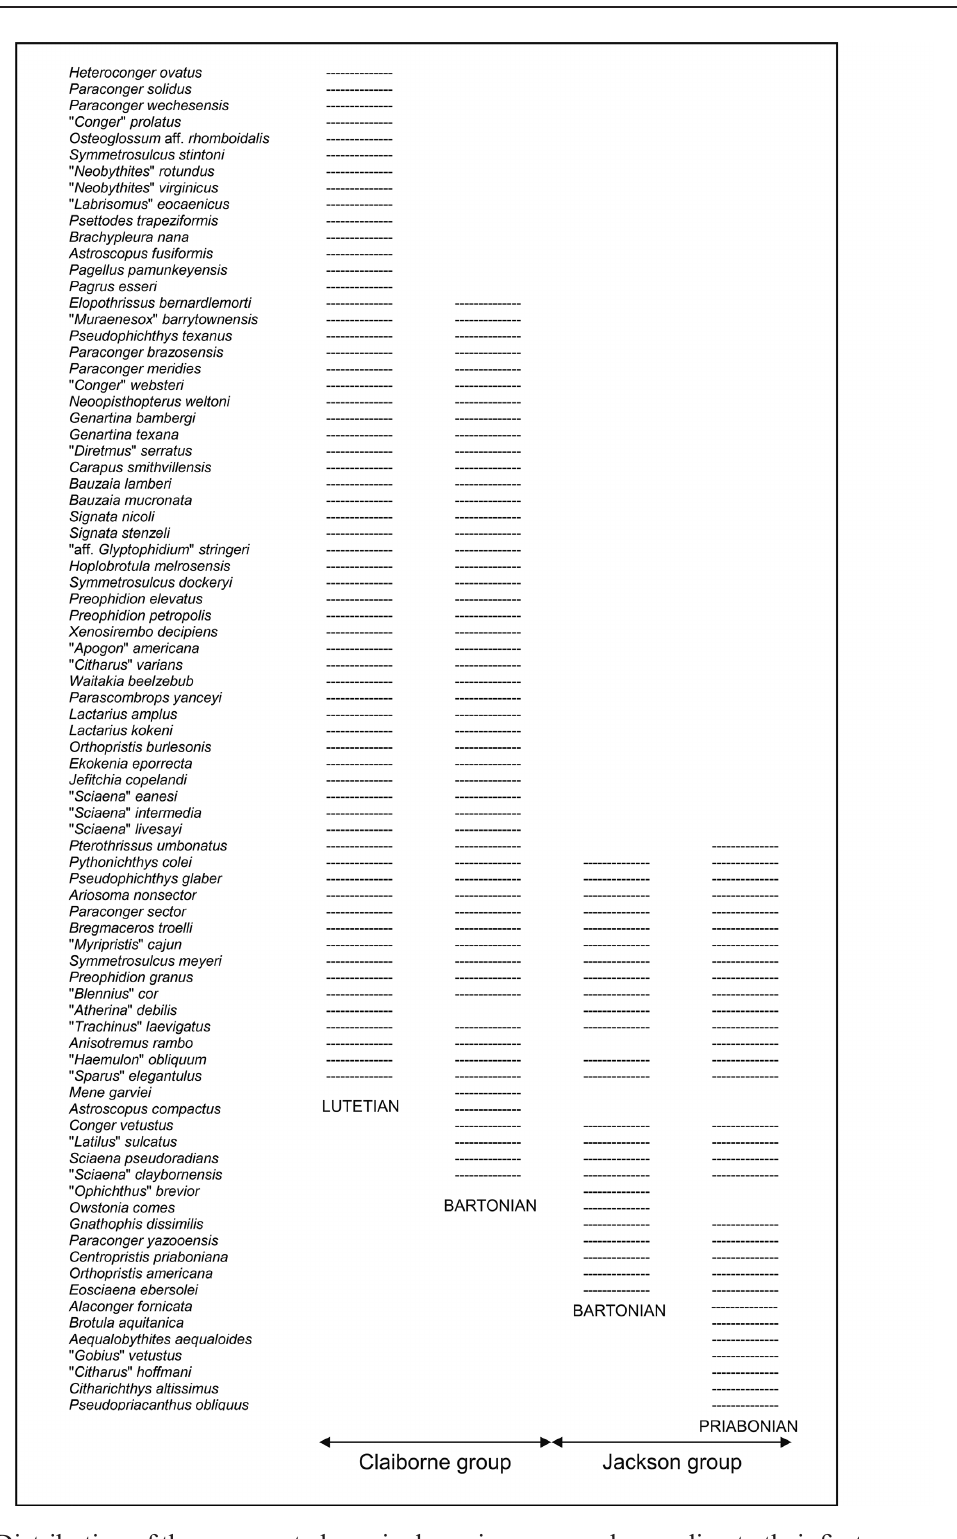
Fig. 41. Distribution of the represented nominal species, arranged according to their first appearance and stratigraphic ranges, illustrating the totality of the represented species in a lower “Claiborne” Group of 68 ones and an upper “Jackson” Group of 32 different species. The Priabonian taxon Muraenanguilla aff. thevenini (Priem, 1906) is not taken into consideration here, because the type of the nominal species already appeared in the Ypresian of the Paris